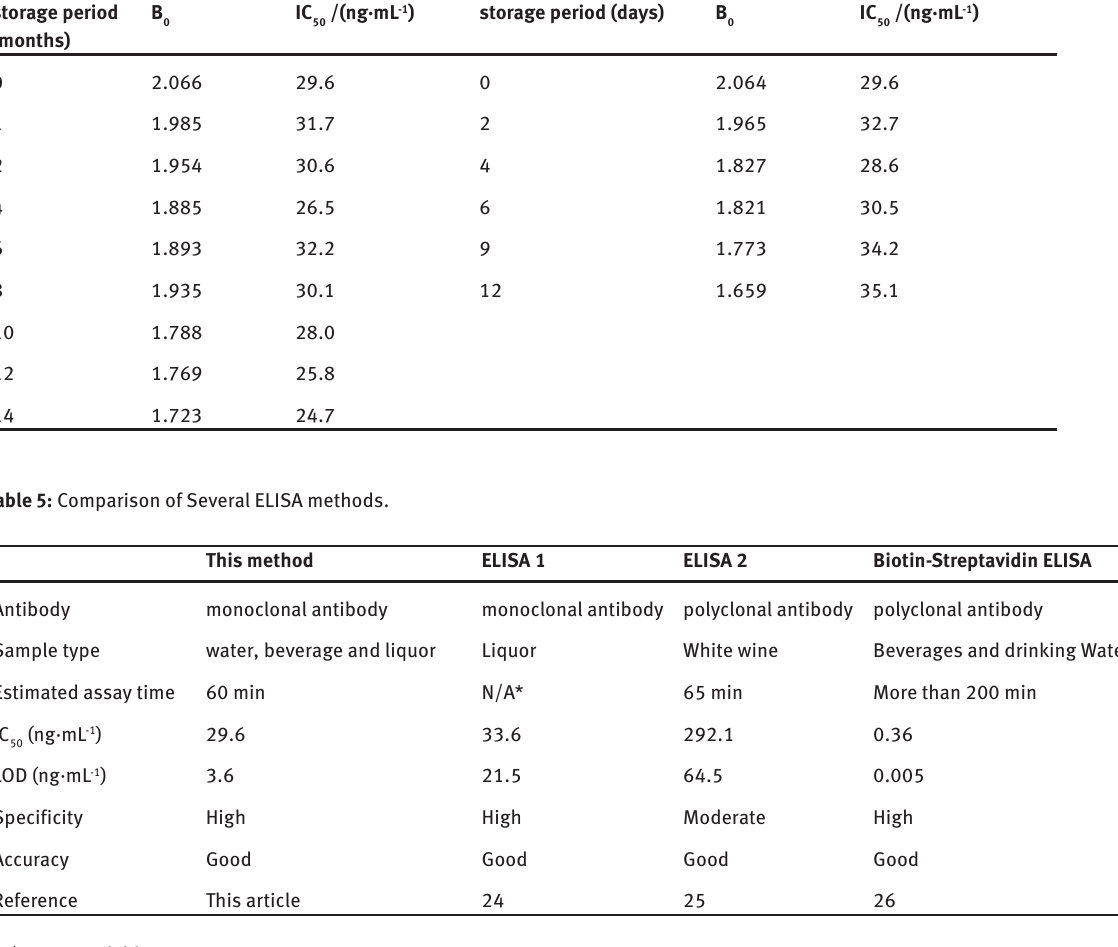
Table 4: Results for accelerated stability of ELISA kits. ( n =3). Stored at 4 °C